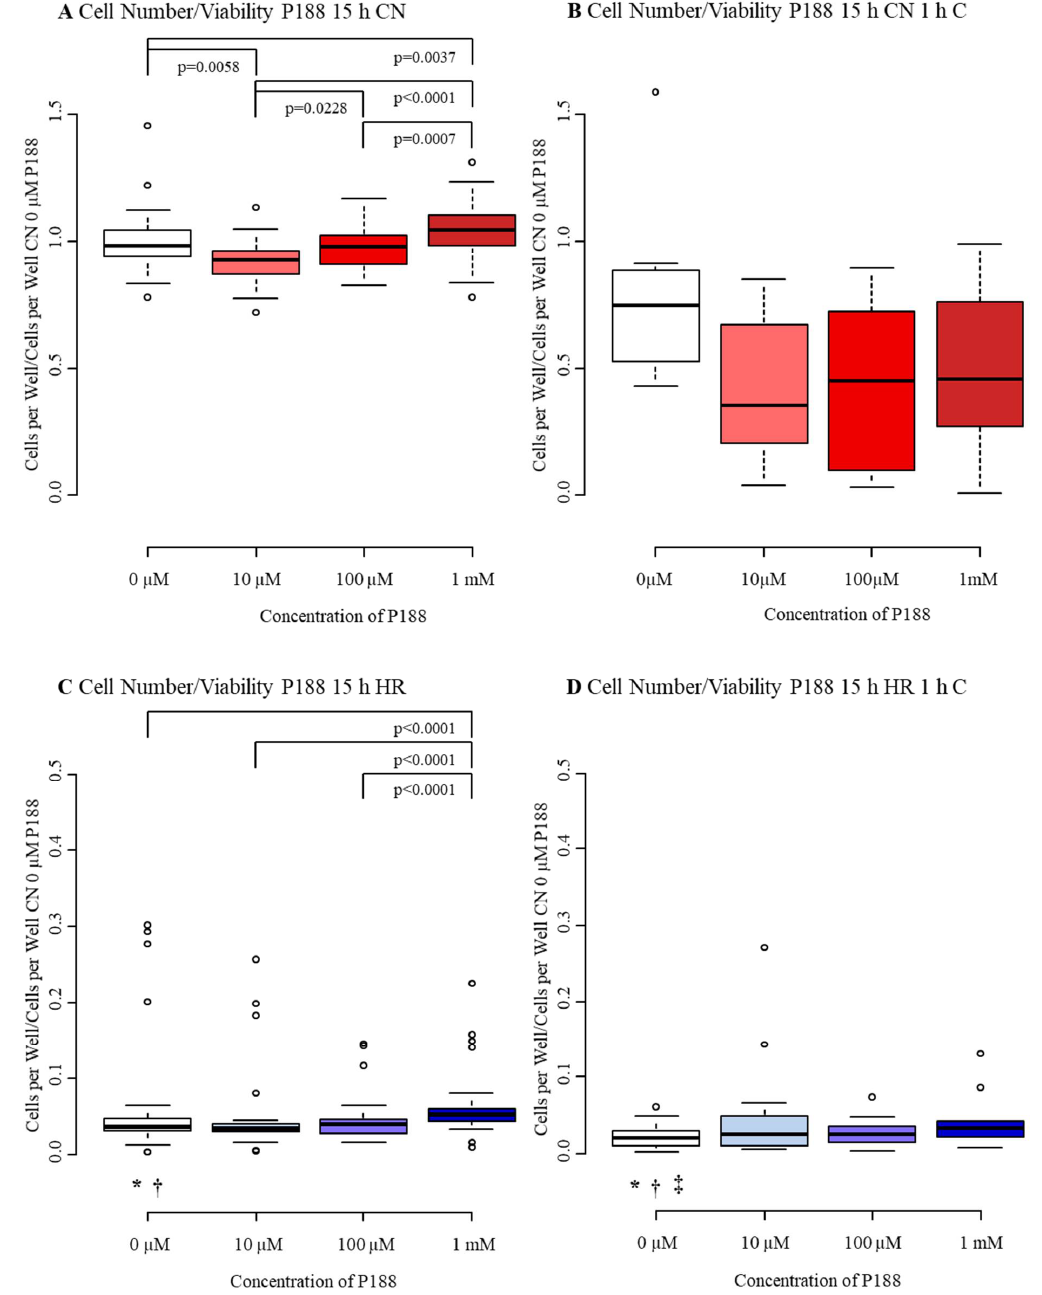
Figure A1. Cell number/viability after 15 h injury and treatment with 0 µ M, 10 µ M, 100 µ M, and 1 mM of P188. ( A ) normoxia (CN-C); ( B ) normoxia and 1 h compression (CN+C); ( C ) hypoxia(HR-C); ( D ) hypoxia and 1 h compression (HR+C). Data visualized as boxplots (median, 25th, 75th percentile, whiskers: minimum, maximum, dots: potential outliers); p < 0.05; n = 4 experiments/group. Significances between different concentrations of P188 are displayed as brackets, significances between ( A – D ) for 0 µ M P188 are represented by symbols (* vs. CN-C 0 µ M P188, † vs. CN+C 0 µ M P188, ‡ vs. HR-C 0 µ M P188). Abbreviations: C, compression; CN, control/normoxia; h, hours; HR, hypoxia/reoxygenation; mM, millimolar; µ M, micromolar; P188, Poloxamer 188. Colors: red, normoxia; blue, hypoxia/reoxygenation. The shadows of red/blue represent the different concentrations of